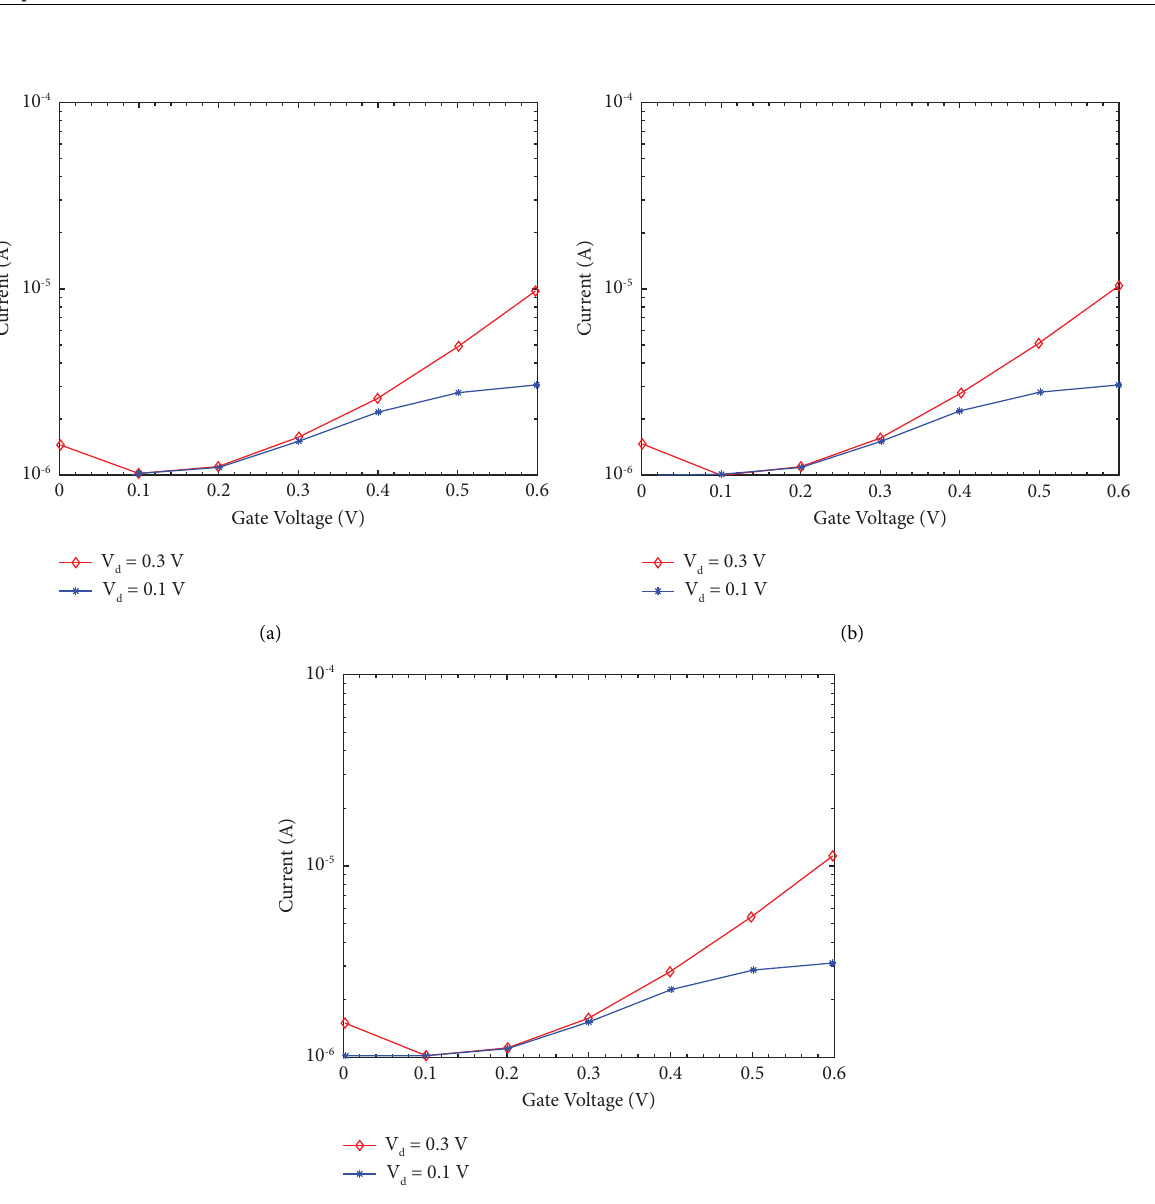
Figure 3: I–V characteristics of SB-GNR-FETs with diferent channel lengths: (a) L at low and high drain